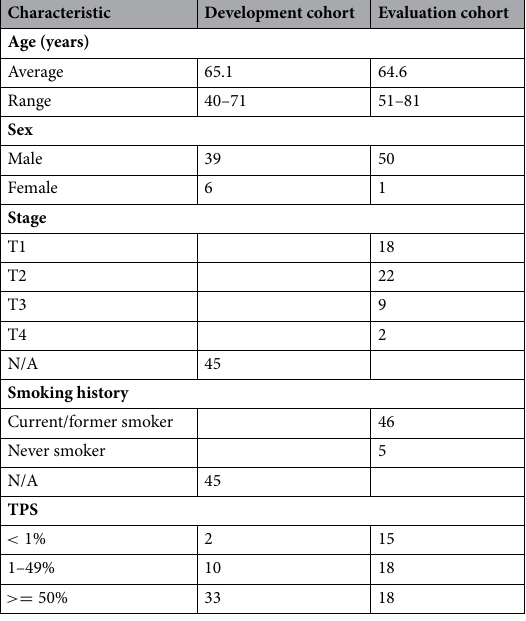
Table 1. Baseline characteristics in the development and evaluation